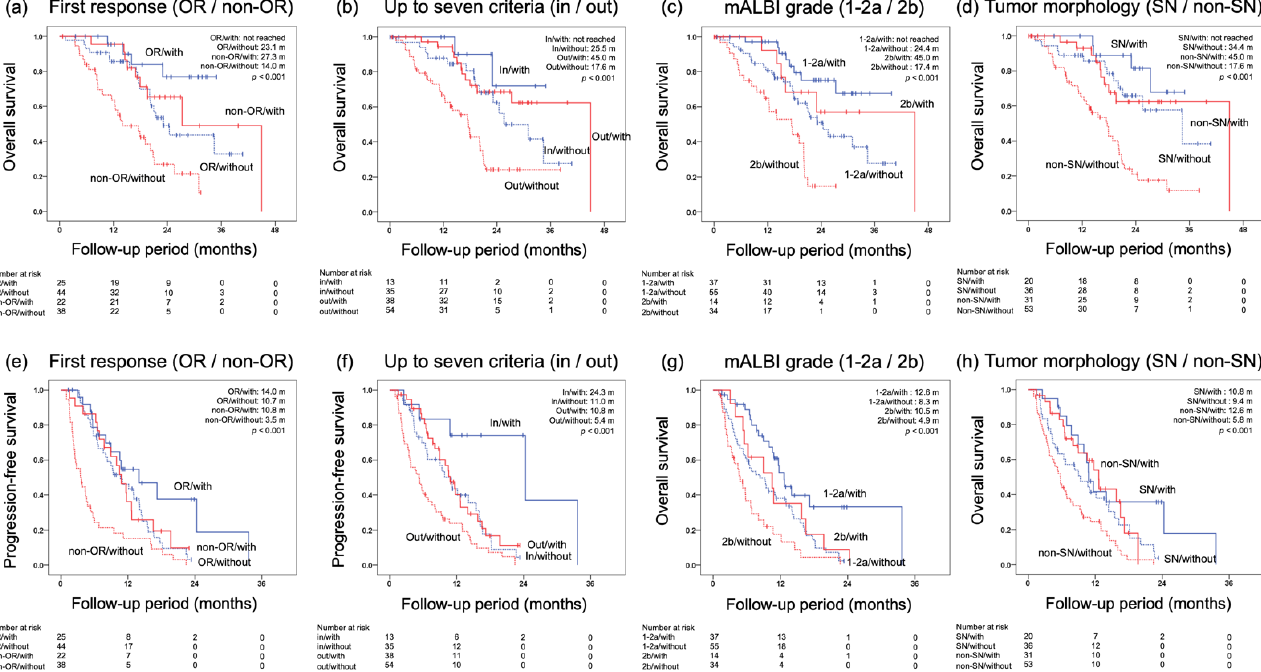
Figure 3. Comparison of overall survival (OS) and progression-free survival (PFS) by four factors, focusing on transarterial chemoembolization (TACE) in combination. ( a ) OS by the response at the first evaluation and TACE combination (objective response (OR)/with TACE not-reached, OR/without TACE 23.1 months, non-OR/with TACE 27.3 months, non-OR/without TACE 14.0 months, p < 0.001). ( b ) OS by up to seven criteria and TACE combination (up to seven criteria in/with TACE not-reached, up to seven criteria in/without TACE 25.5 months, up to seven criteria out/with TACE 45.0 months, up to seven criteria out/without TACE 17.6 months, p < 0.001). ( c ) OS by tumor morphology and TACE combination (simple nodular [SN]/with TACE not-reached, SN/without TACE 34.4 months, non-SN/with TACE 45.0 months, non-SN/without TACE 17.6 months, p < 0.001). ( d ) OS by modified albumin–bilirubin (mALBI) grade and TACE combination (mALBI 1–2a/with TACE not-reached, mALBI 1–2a/without TACE 24.4 months, mALBI 2b/with TACE 45.0 months, mALBI 2b/without TACE 17.4 months, p < 0.001). ( e ) PFS by the response at the first evaluation and TACE combination (OR/with TACE 14.0 months, OR/without TACE 10.7 months, non-OR/with TACE 10.8 months, non-OR/without TACE 3.5 months, p < 0.001). ( f ) PFS by up to seven criteria and TACE combination (up to seven criteria in/with TACE 24.3 months, up to seven criteria in/without TACE 11.0 months, up to seven criteria out/with TACE 10.8 months, up to seven criteria out/without TACE 5.4 months, p < 0.001). ( g ) PFS by mALBI grade and TACE combination (mALBI 1–2a/with TACE 12.6 months, mALBI 1–2a/without TACE 8.3 months, mALBI 2b/with TACE 10.5 months, mALBI 2b/without TACE 4.9 months, p < 0.001). ( h ) PFS by tumor morphology and TACE combination (SN/with TACE 10.8 months, SN/without TACE 9.4 months, non-SN/with TACE 12.6 months, non-SN/without TACE 5.8 months, p <